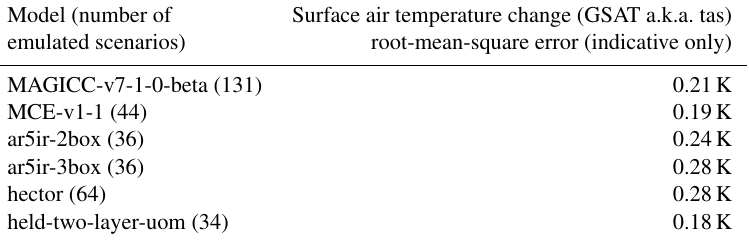
Figure 1. Historical global-mean annual mean surface air temperature (GSAT) simulations. Thick black line is observed GSAT (Richardson et al., 2016; Rogelj et al., 2019). Medium-thickness lines are default configurations for RCMIP models. Thin grey solid lines are CMIP6 models. In order to provide time series up until 2019, we have used data from the combination of historical and ssp585 simulations. Table 2. Model emulation scores over all emulated models and scenarios. Here we provide root-mean-square errors over the SSPs plus four idealised CO 2 -only experiments (abrupt-2xCO2, abrupt-4xCO2, abrupt-0p5xCO2, 1pctCO2). As the models have not all provided emulations for the same set of target models and scenarios, the model emulation scores are indicative only and are not a true, fair test of skill. For target model by target model emulation scores, see Table